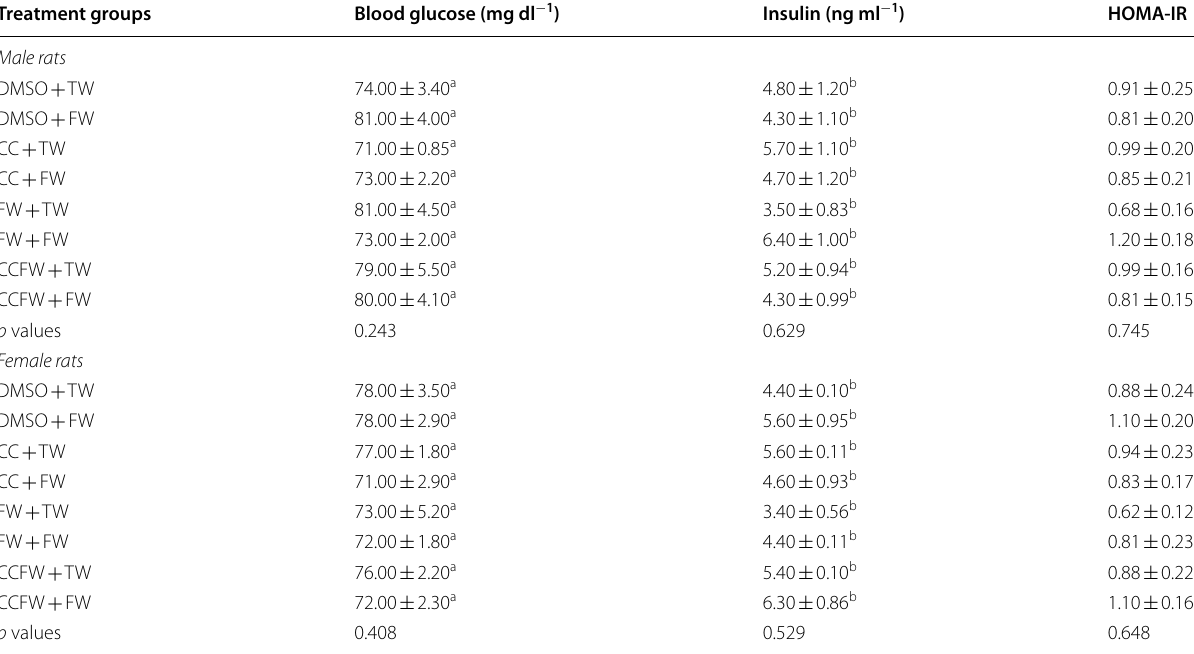
a, b, c Means across columns (in males and females) with similar superscripts are similar ( p > 0.05) using one-way ANOVA across all eight groups. Using ANOVA between all eight groups for fasting blood glucose, plasma insulin concentration and HOMA-IR of the male and female rats. FBG, fasting blood glucose; HOMA-IR,